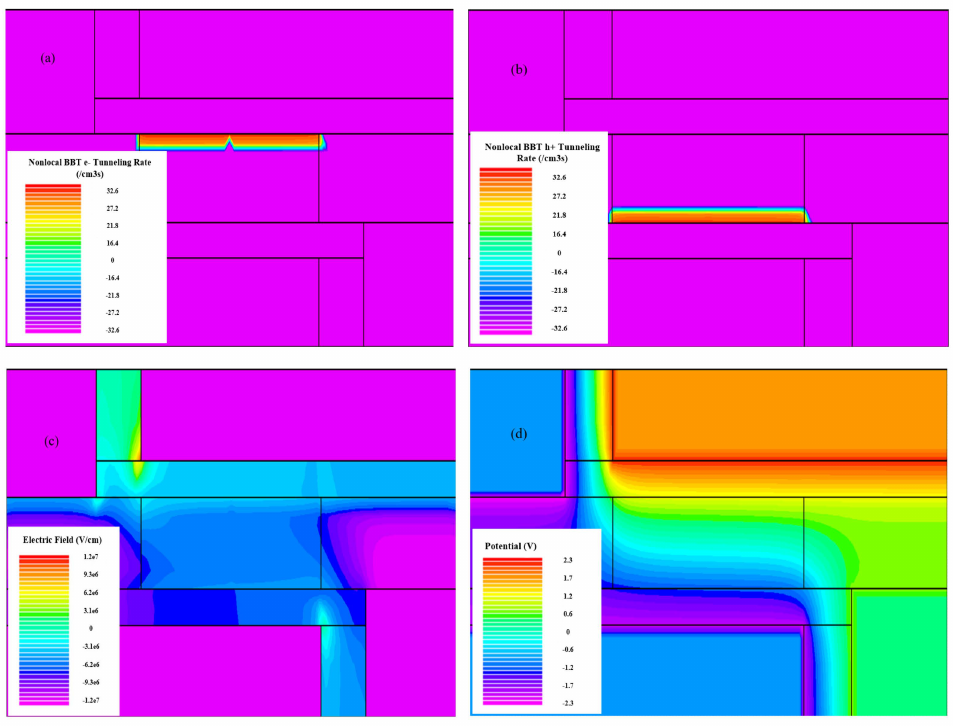
Figure 4. ( a ) e-BTBT rate; ( b ) h-BTBT rate; ( c ) Electric field; and ( d ) Potential distribution of the H-DLTFET.